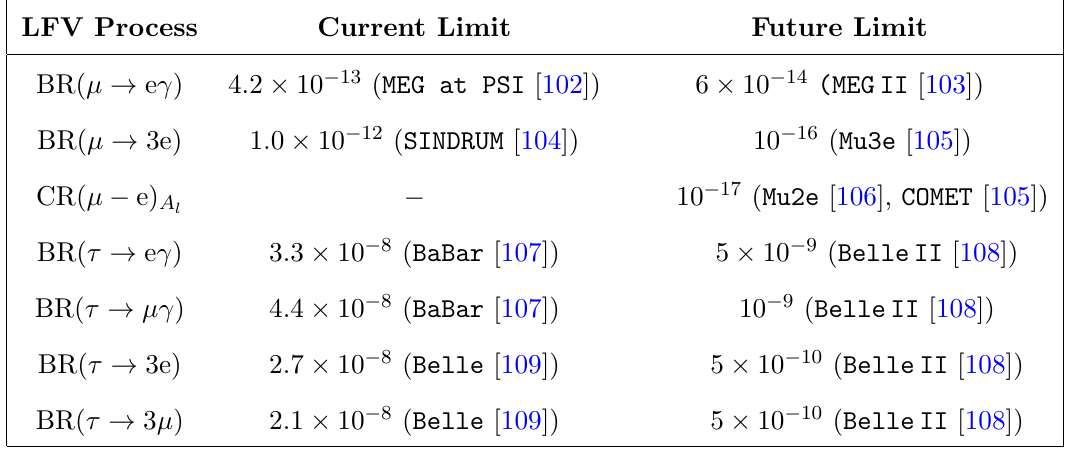
Table 2 . Current and future expected limits on CLFV